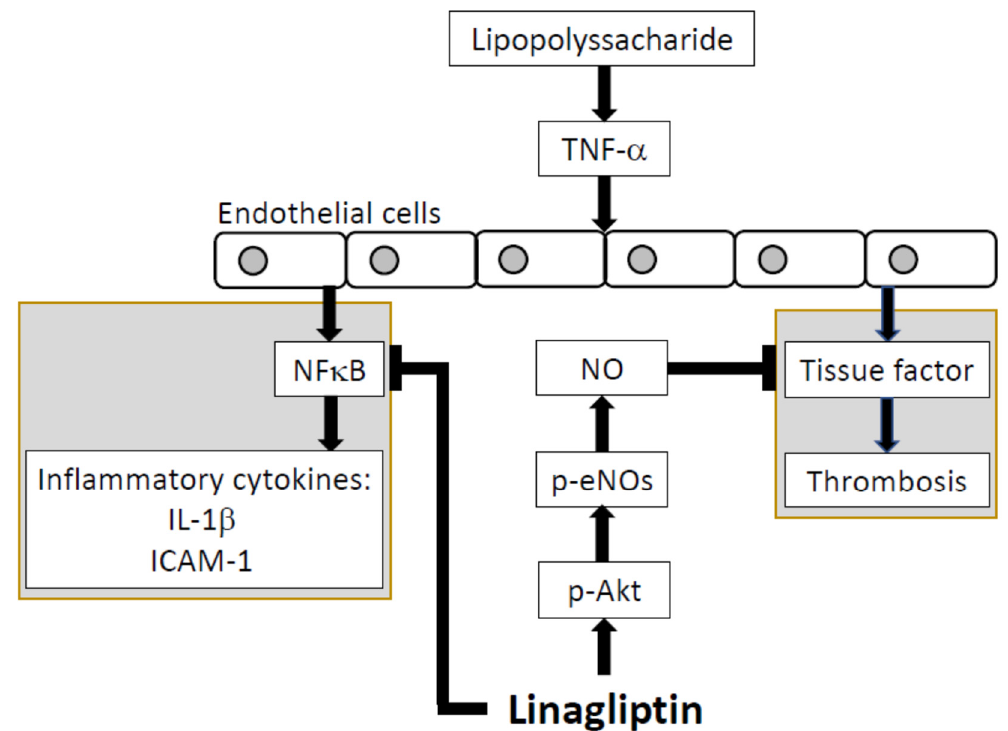
Figure 5. Proposed mechanism. Through inhibition of the NF κ B p65 subunit, linagliptin can down- regulate IL-1 β and ICAM-1 expression. By increasing eNOS expression, linagliptin can ameliorate tissue factor activity.